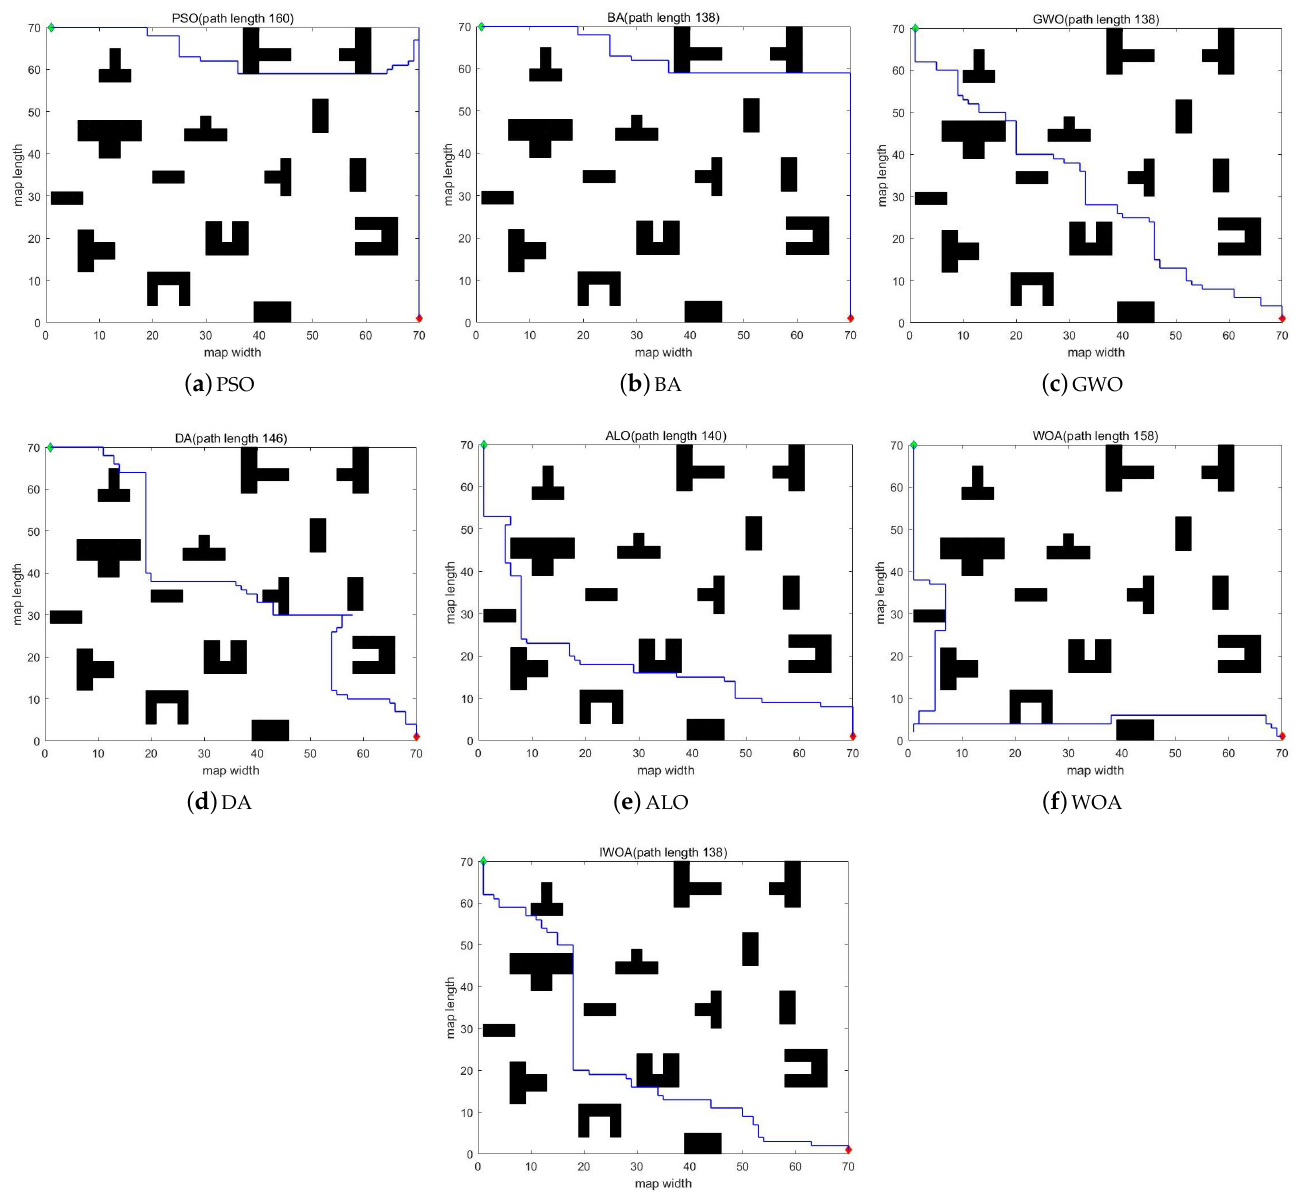
Figure 17. Actual path traces of seven different algorithms on 70 × 70 size